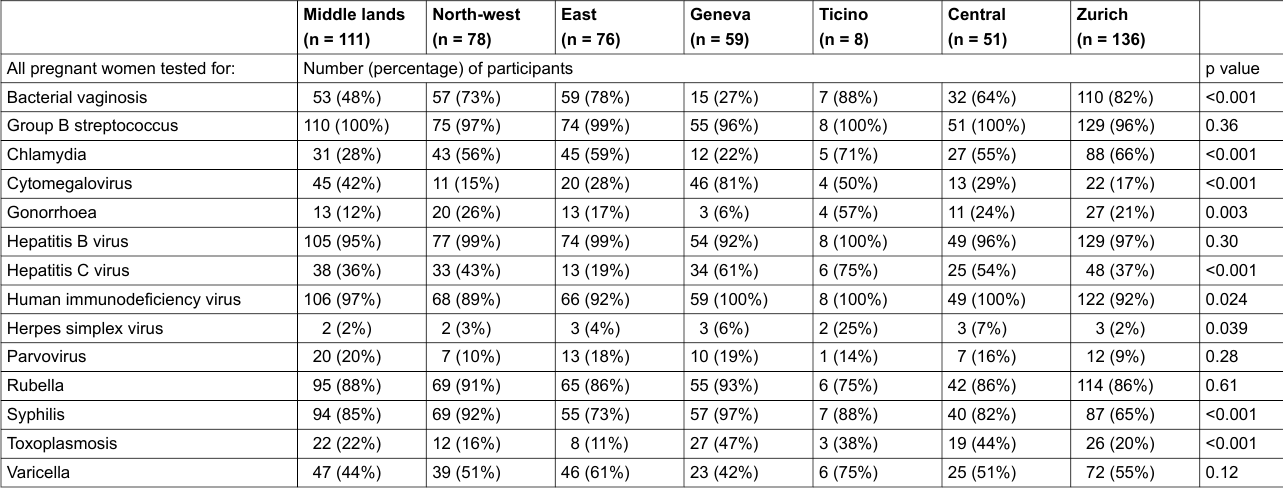
Table 2: Number and percentage of participants testing all pregnant women by